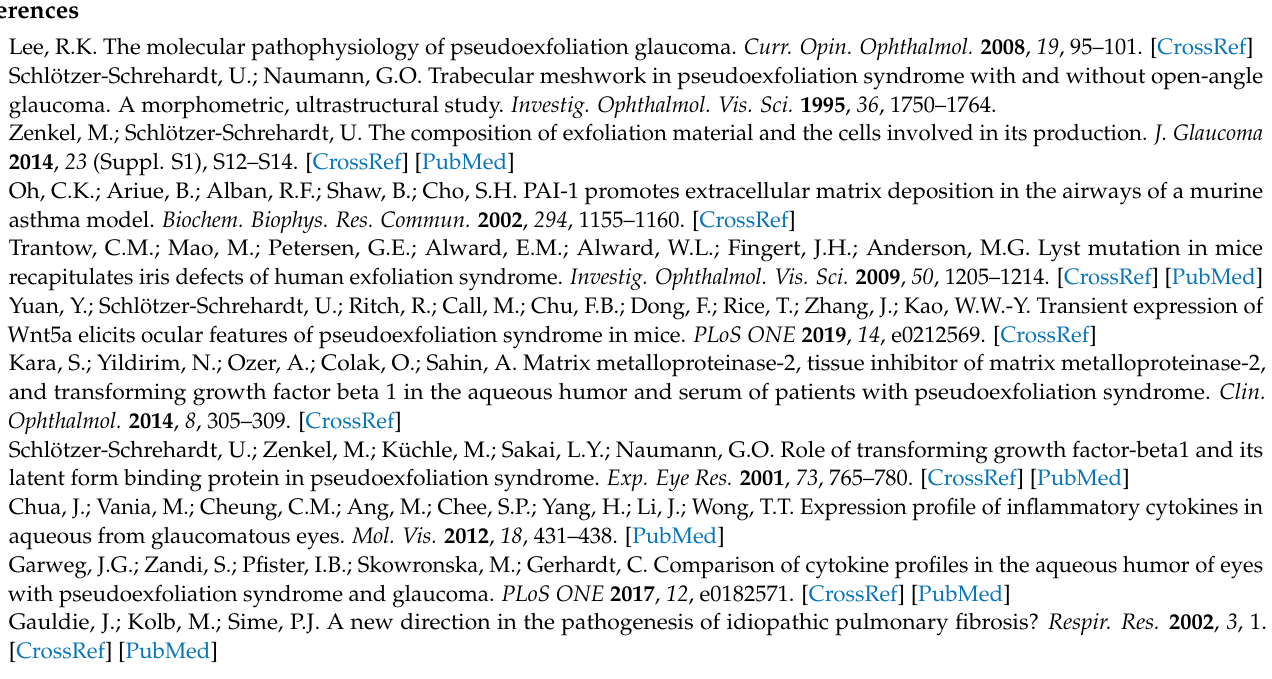
Figure S2: Apoptosis analysis by FACS after TGF- β 1 (5 ng/mL, 10 ng/mL, 15 ng/mL) treatment for 24 h, 48 h, and 72 h; Figure S3: Morphological changes in TM cells after TGF- β 1 treatment quantified using ImageJ software (a) percent of total cells undergoing change in length compared to control cells, (b) average change in the length between cells in control and treated group; Figure S4: relative mRNA expression of (a) various ECM genes quantified by quantitative RT-PCR after 15 ng/mL of TGF- β 1 exposure, (b) IL-6 quantified after 10 ng/mL of TGF- β 1 exposure and (c) Il-8 quantified after 10 ng/mL of TGF- β 1 exposure; Figure S5: phopho Smad3 levels in control and TGF- β 1 treated TM